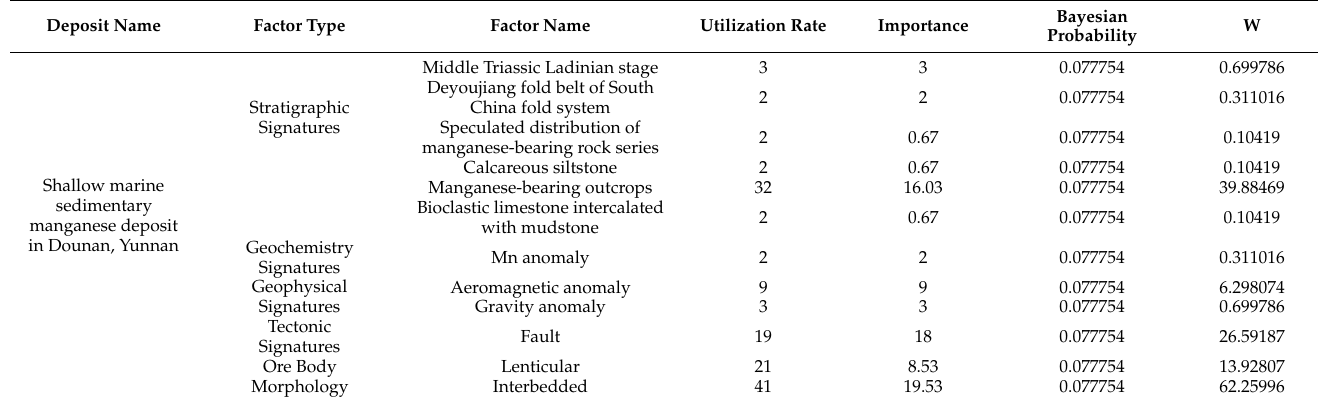
Table 7. An example of importance, utilization rate, and Bayesian probability weighting calculation.